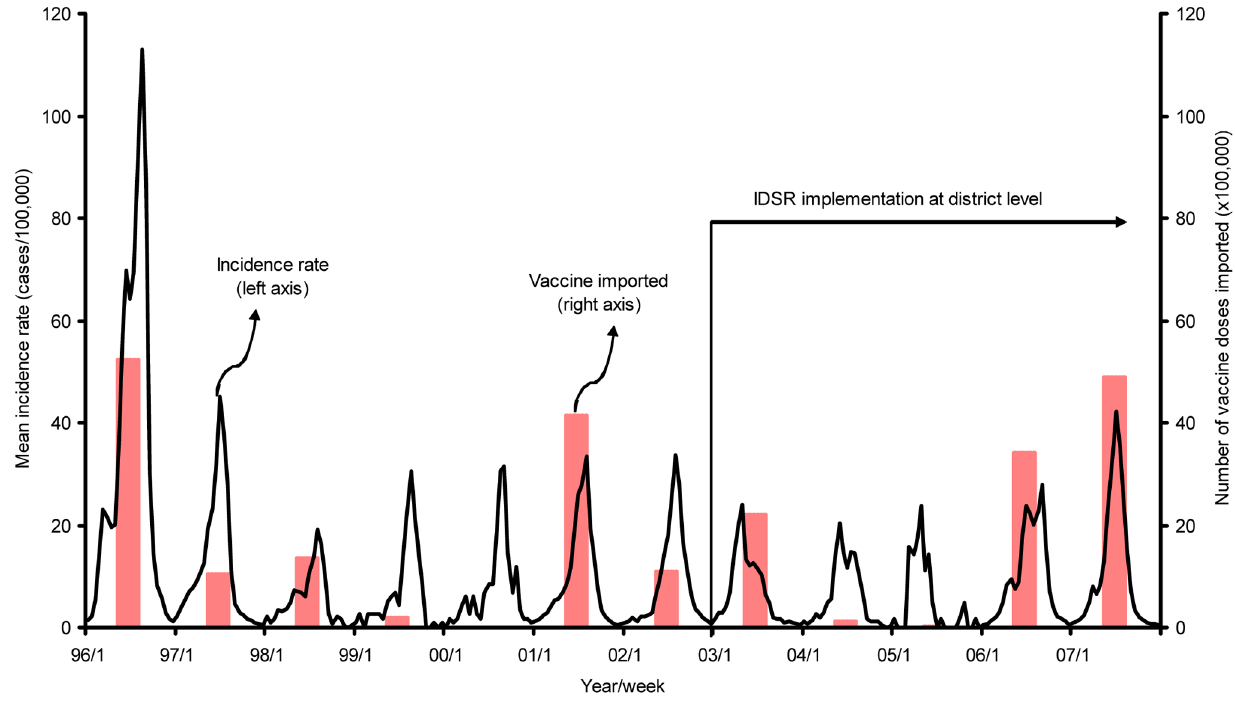
Figure 1. Weekly number of meningococcal meningitis cases (all serotypes) reported during the meningitis season (week 1 to 23) and number of doses of meningococcal vaccine imported from 1996 to 2007 in Burkina Faso. Note: District level weekly new meningitis cases from Burkina Faso for the years 1996–2007 were obtained from the WHO Multi-Diseases Surveillance Center in Ouagadougou, Burkina Faso. Incidence recorded in a particular district experiencing a meningitis outbreak - the incidence data do not apply to the entire country. For list of districts reporting outbreaks recorded in this Figure, see Table S2. Doses of vaccine include all bivalent (AC), trivalent (ACW), and tetravalent (ACWY) polysaccharides imported by the government of Burkina Faso through different organizations (WHO-ICG, UNICEF, MSF, and GlaxoSmithKline Biologicals). Dates of vaccine shipment are representation for purpose of graphing (see also Tables S3 and S4).